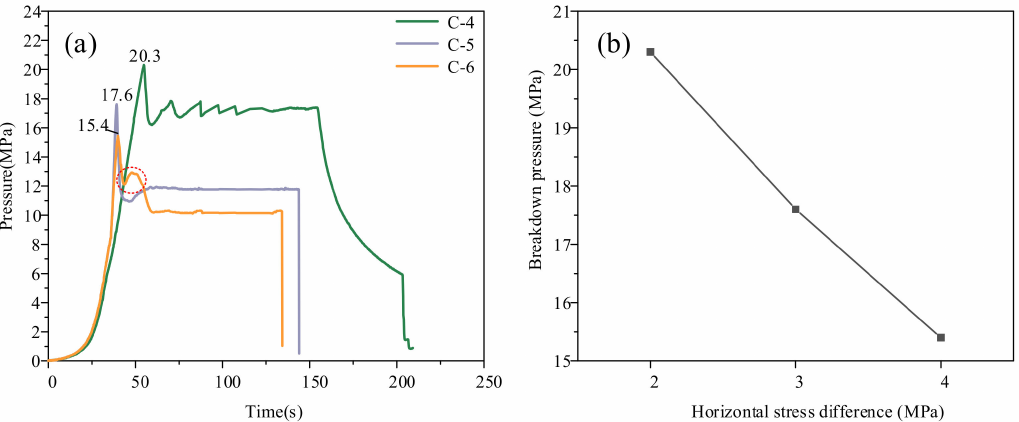
Figure 11. Pressure curves and breakdown pressures for different horizontal stress differences: ( a ) pressure curves and ( b ) breakdown pressures. (The red circle reflected the interaction between the vug and the hydraulic